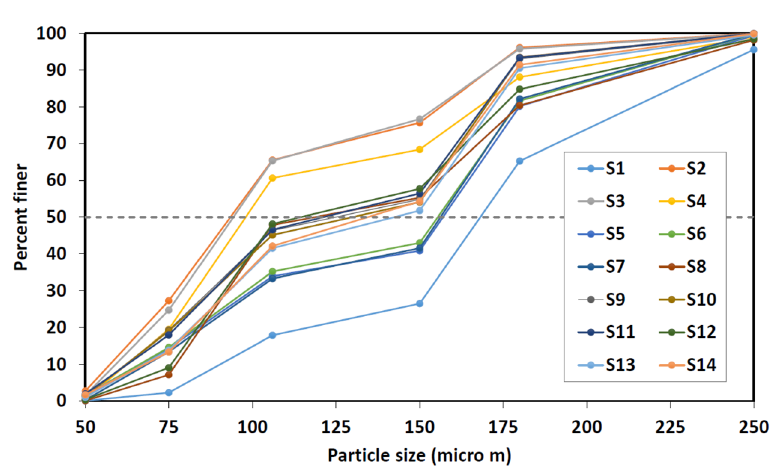
Figure 5. Particle-size distribution for 14 sand samples, labeled as S1, S2, …,